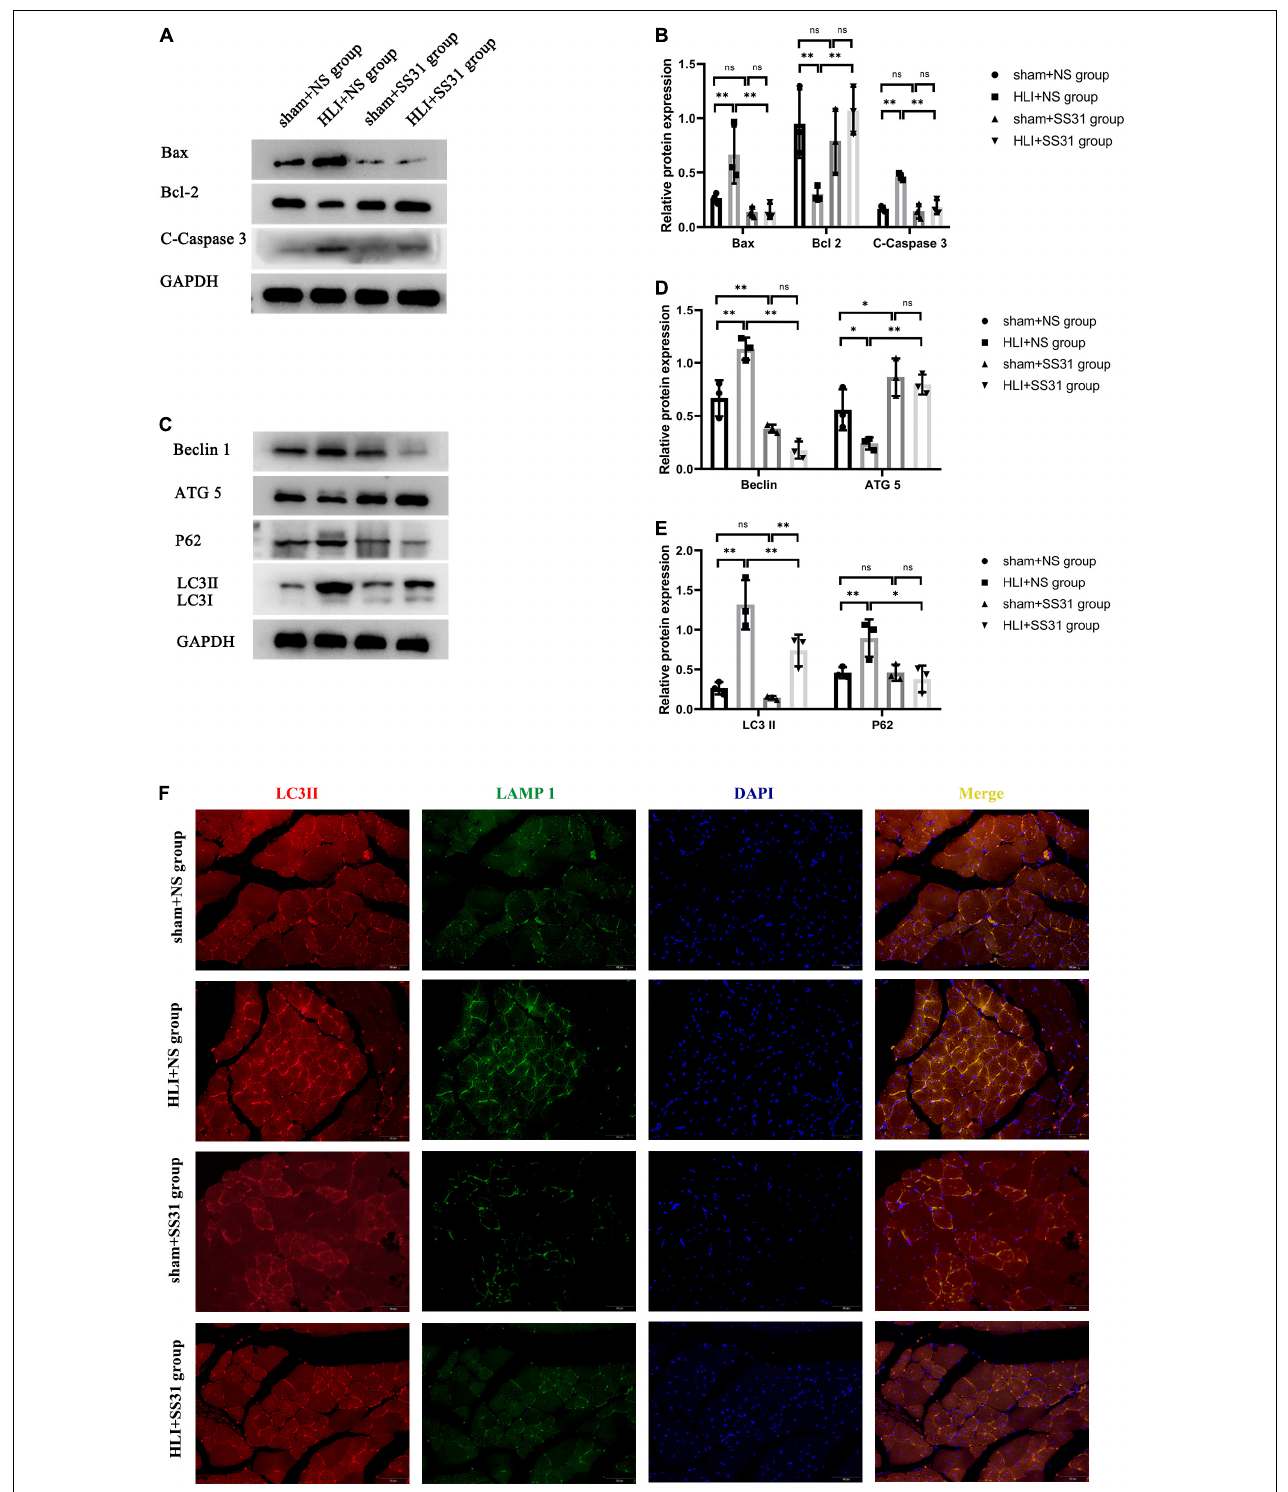
FIGURE 2 | SS31 inhibits apoptosis and restores autophagic flux in HLI mouse model. (A,B) The expression levels of apoptosis-related proteins were detected by WB. GAPDH was used as a control. (C–E) Immunoblot analysis showing the protein levels of LC3 II, P62, Beclin1, and ATG5. Western blot results were analyzed for LC3 II expression and normalized to GAPDH expression, P62 normalized to GAPDH, Beclin1 normalized to GAPDH, and ATG5 normalized to GAPDH. (F) LC3II (red) and LAMP1 (green) were detected by immunofluorescence. Nuclei are labeled with DAPI (blue) (magnification of × 400). n = 3. ∗ p < 0.05, ∗∗ p < 0.01.